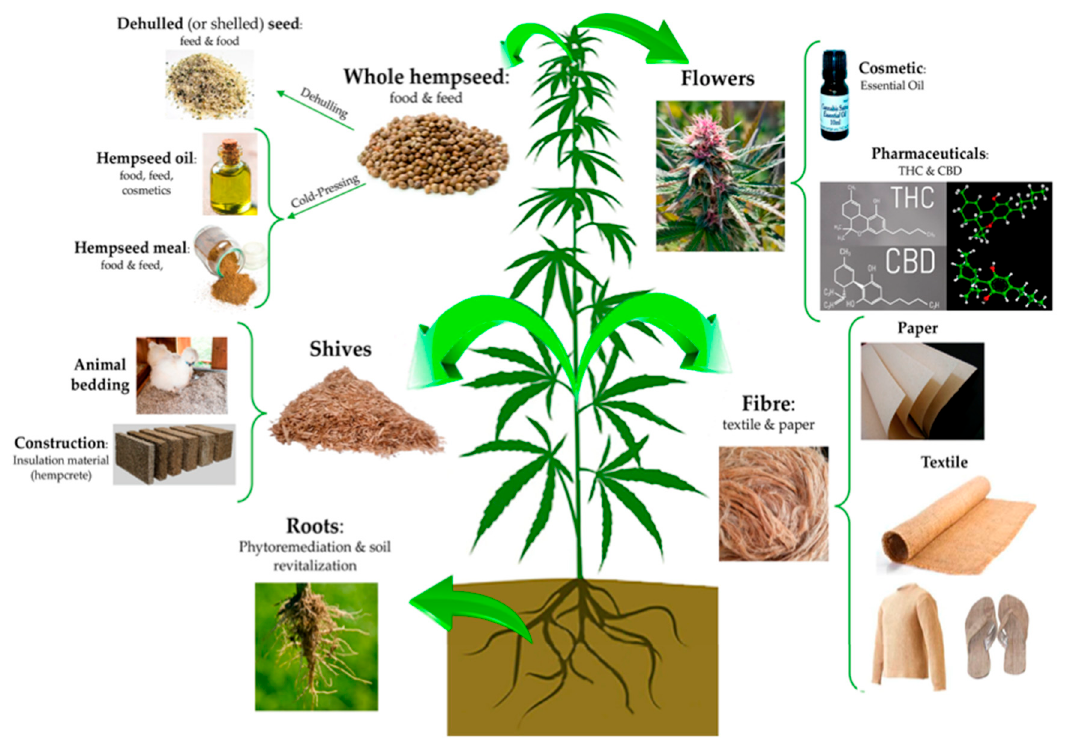
Figure 1. Industrial applications of hemp plant. (Reproduced with permission from Farinon et al., Nutrients; published by MDPI, 2020. [1] ).